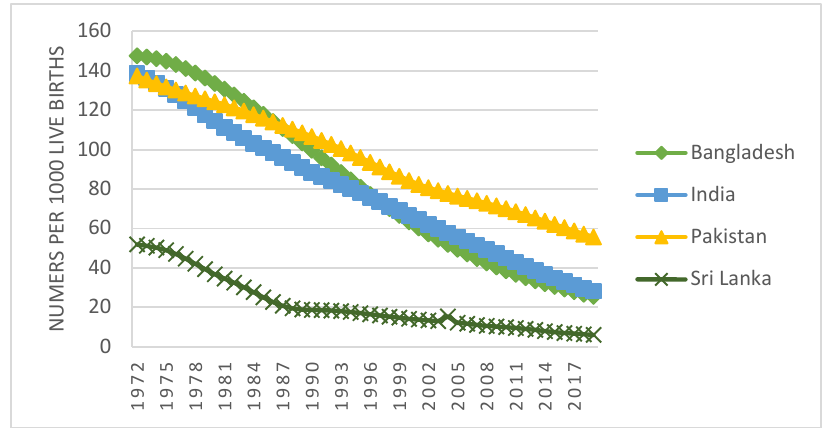
Figure 2. Infant Mortality Rate in Selected South Asian Countries. Source: World Bank